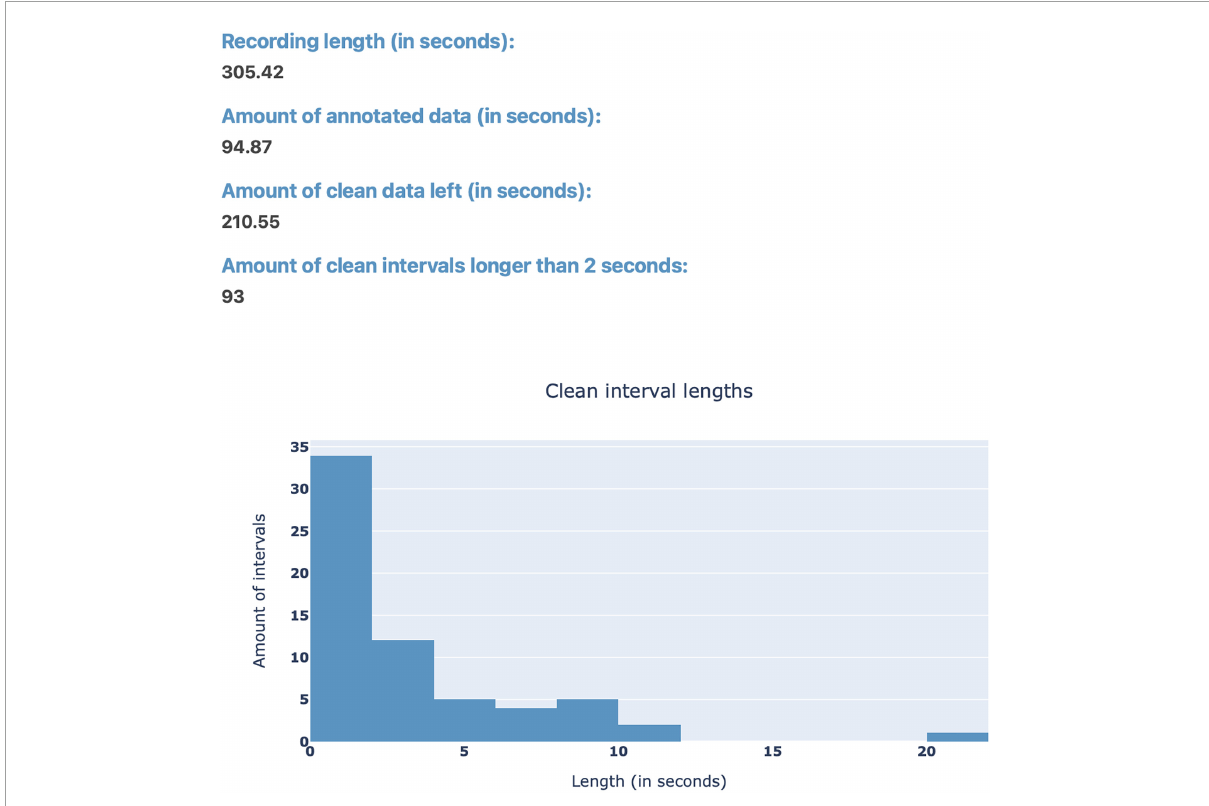
FIGURE3 The “Stats” pop-up window offers an overview over the annotated data. Currently, the integrated statistics consist of the recording’s total length (in seconds), the amount of annotated (artifact) and non-annotated (artifact-free) data (in seconds), as well as the amount of consecutive, non-annotated (artifact-free) intervals longer than 2 s. Finally, there is a histogram to show the distribution of the length of non-annotated data.